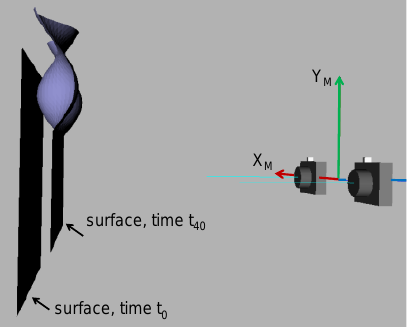
Figure 4. Simulated imaging